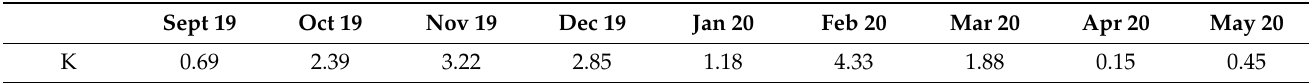
Table 1. Hydrothermal Sielianinov coefficients (K) during the growing season according to the Meteorological Station at Campus Klein-Altendorf.